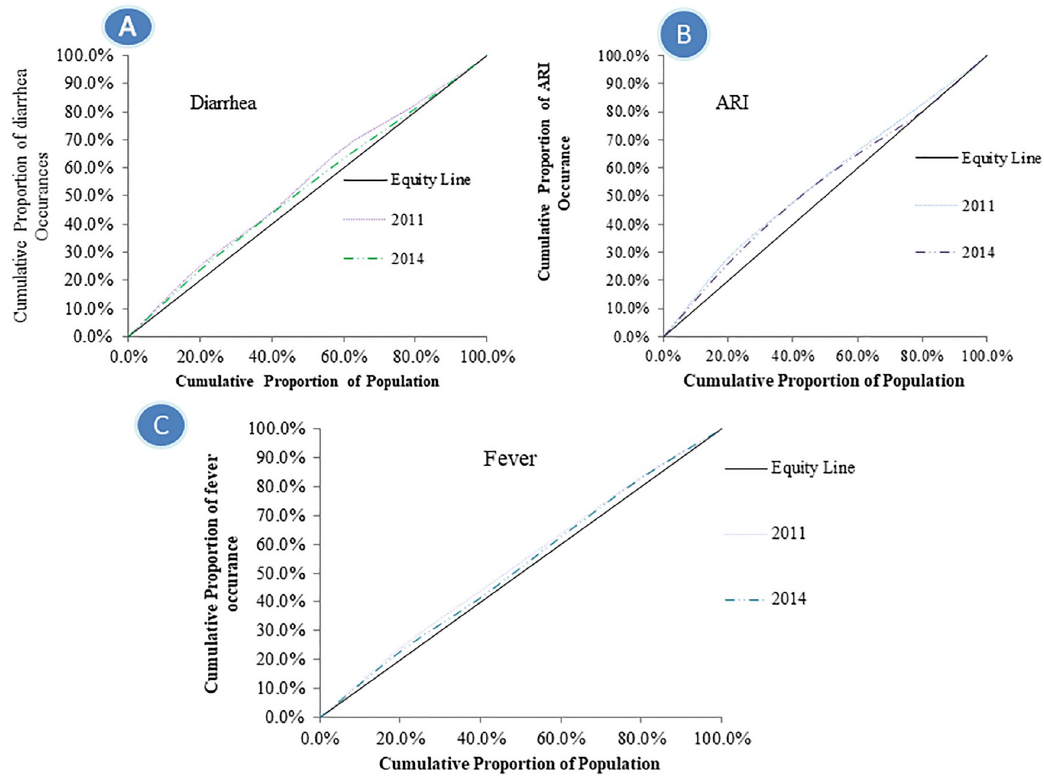
Fig 4. Concentration curve for childhood morbidities over 2011 to 2014. (A) Explicating childhood diarrhea (B) Uttering childhood acute respiratory infection (ARI) (C) Demonstrating childhood fever.